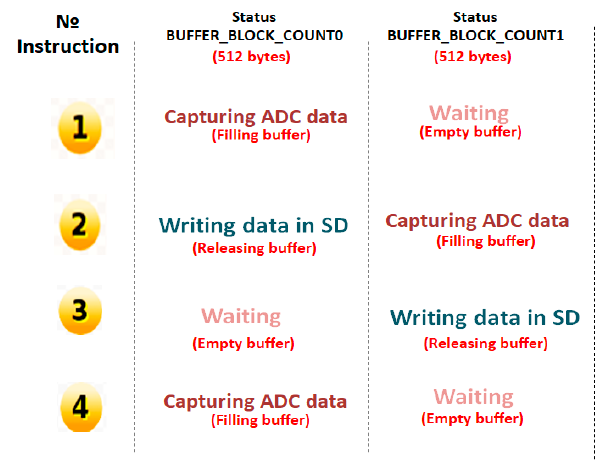
Figure 12. Double buffer implementation for writing data to SD memory.